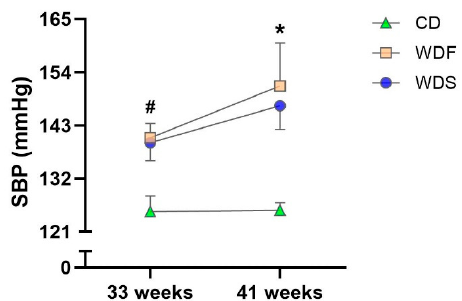
Figure 4. Systolic blood pressure (SBP) at 33rd and 41st week of dietary intervention with Control diet (CD), Western diet fat (WDF), and Western diet sugar (WDS). Data are presented as mean ± s.e.m. Two-way repeated-measures ANOVA and Bonferroni’s multiple comparisons test. * p < 0.05 Control vs. WDF and WDS; # p < 0.05 Control vs. WDF (n = 7–10 rats per group).